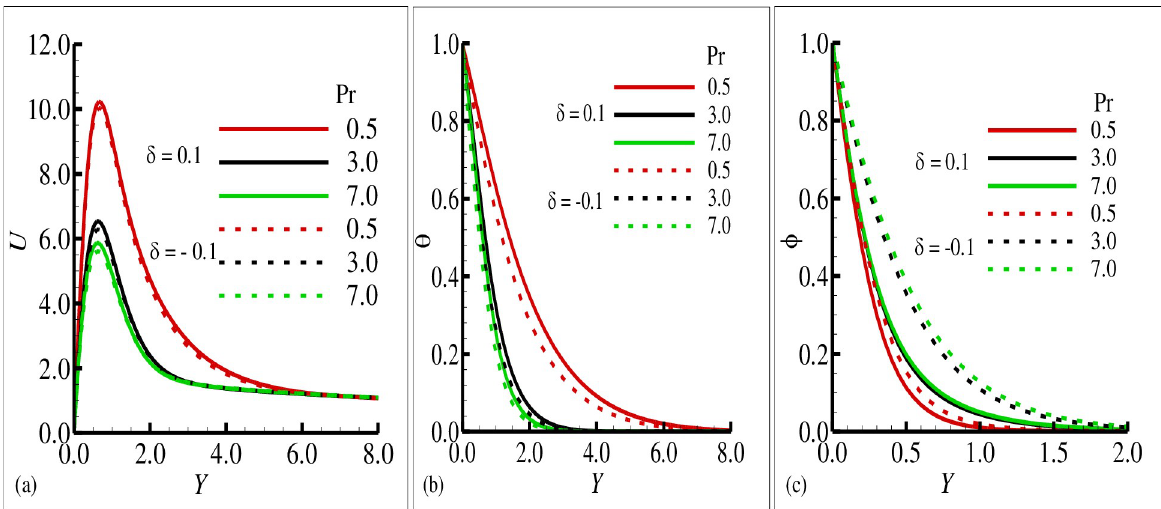
Fig 3. The graphical results for (a) velocity field u , (b) temperature field θ , and (c) magnetic field ϕ with choice values of Pr = 0.5, 3.0, 7.0 for heat source δ = 0.6 and sink δ = − 0.6, where others are γ = 0.4, λ = 0.2, ξ = 0.8, and O = 0.5. https://doi.org/10.1371/journal.pone.0260845.g003 The influence of the source and sink parameter ± δ on the periodical skin friction, heat transfer and current density is presented in Fig 6(A)–6(C), respectively. This is due to the rea- son that because of the increase in sink parameter the heated surface is transfer its energy to the fluid which is at lower temperature than the surface temperature. The second reason is that due to an increase in source parameter the constant heat parameter Q is increase and kinetic o motion of the fluid particle is decreased. In these plots it is very clear that amplitude of periodic skin friction is increased for increasing values of source parameter δ and is reduced in the sink ranges. In the case of periodical heat transfer this trend is reversed, the amplitude of periodic heat transfer is increased in the sink range and reduced in the source range. It is important to point out that the periodical current density is uniform in both rages. The behavior of